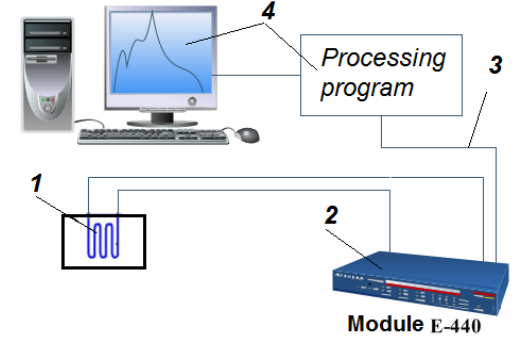
Figure 8. Installation for the acquisition of the force acting on press slide The dependence of the force on the press slide from the slide stroke F =f(h) is shown in Fig. 9. pr